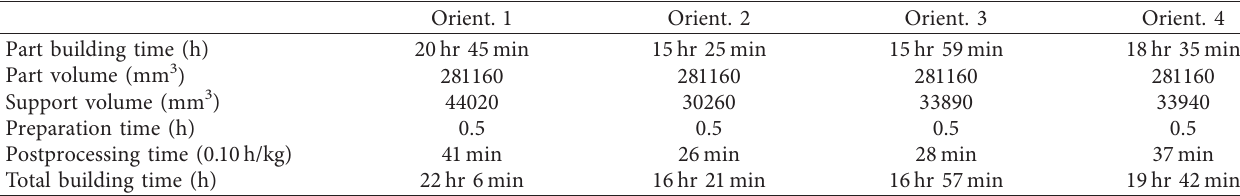
Table 10: Additive process plan.